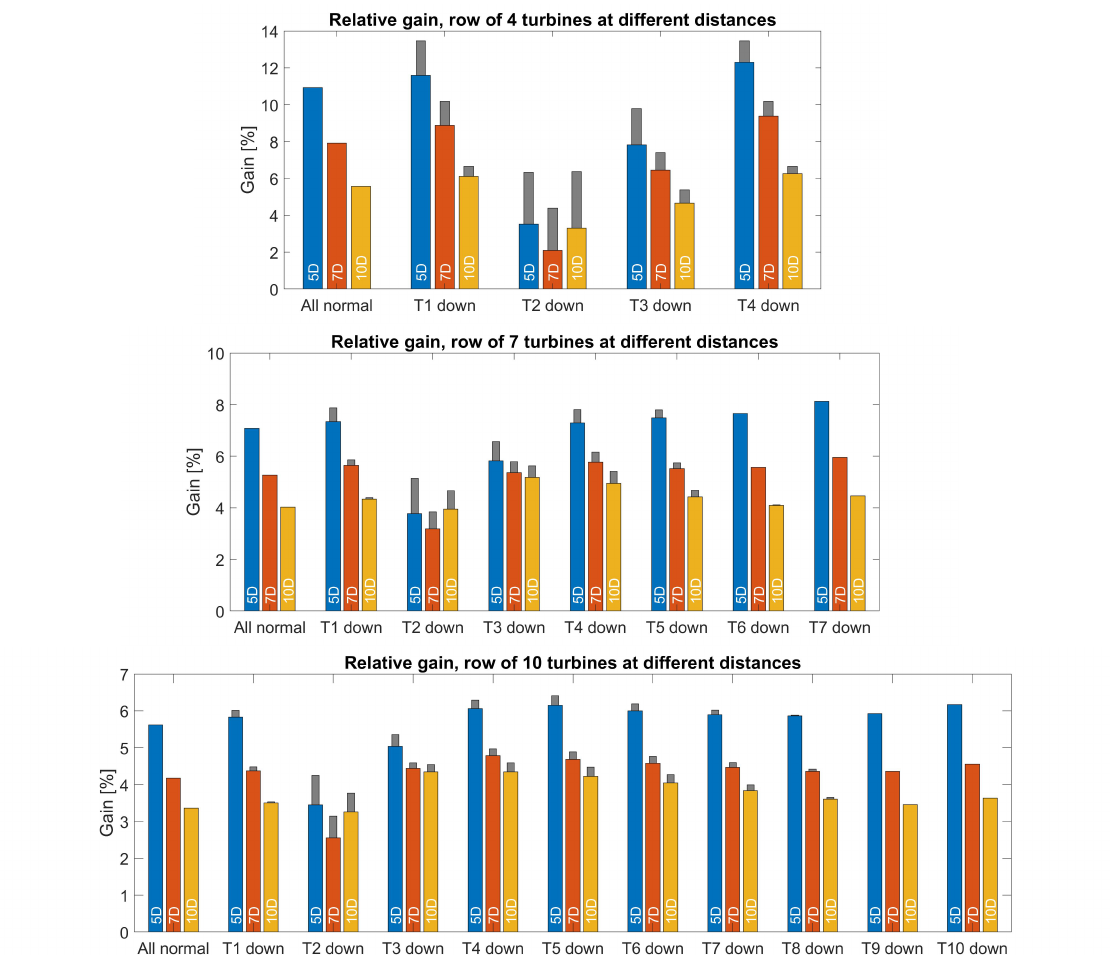
Figure 2. Relative power gain by AWC when one single turbine is not operational, ( middle ) row of 7 wind turbines, ( bottom ) row of 10 wind